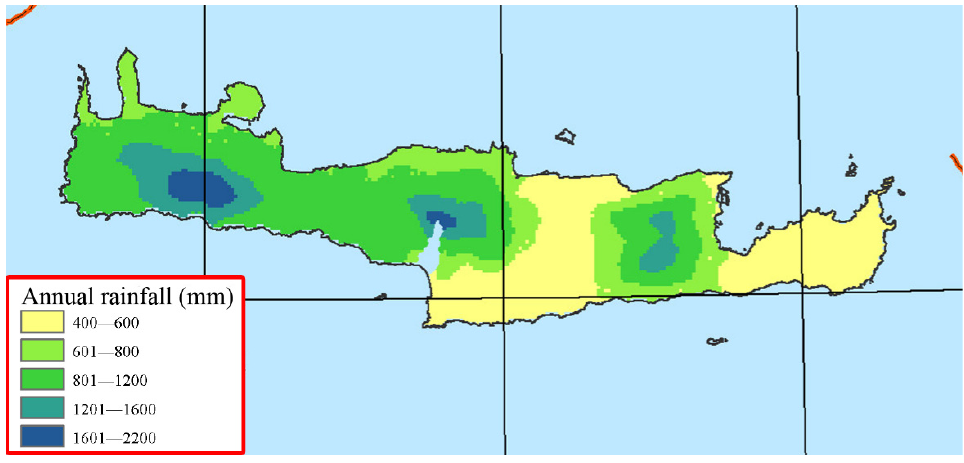
Figure 18. Top: Annual rainfall of Crete (adapted by [209]).